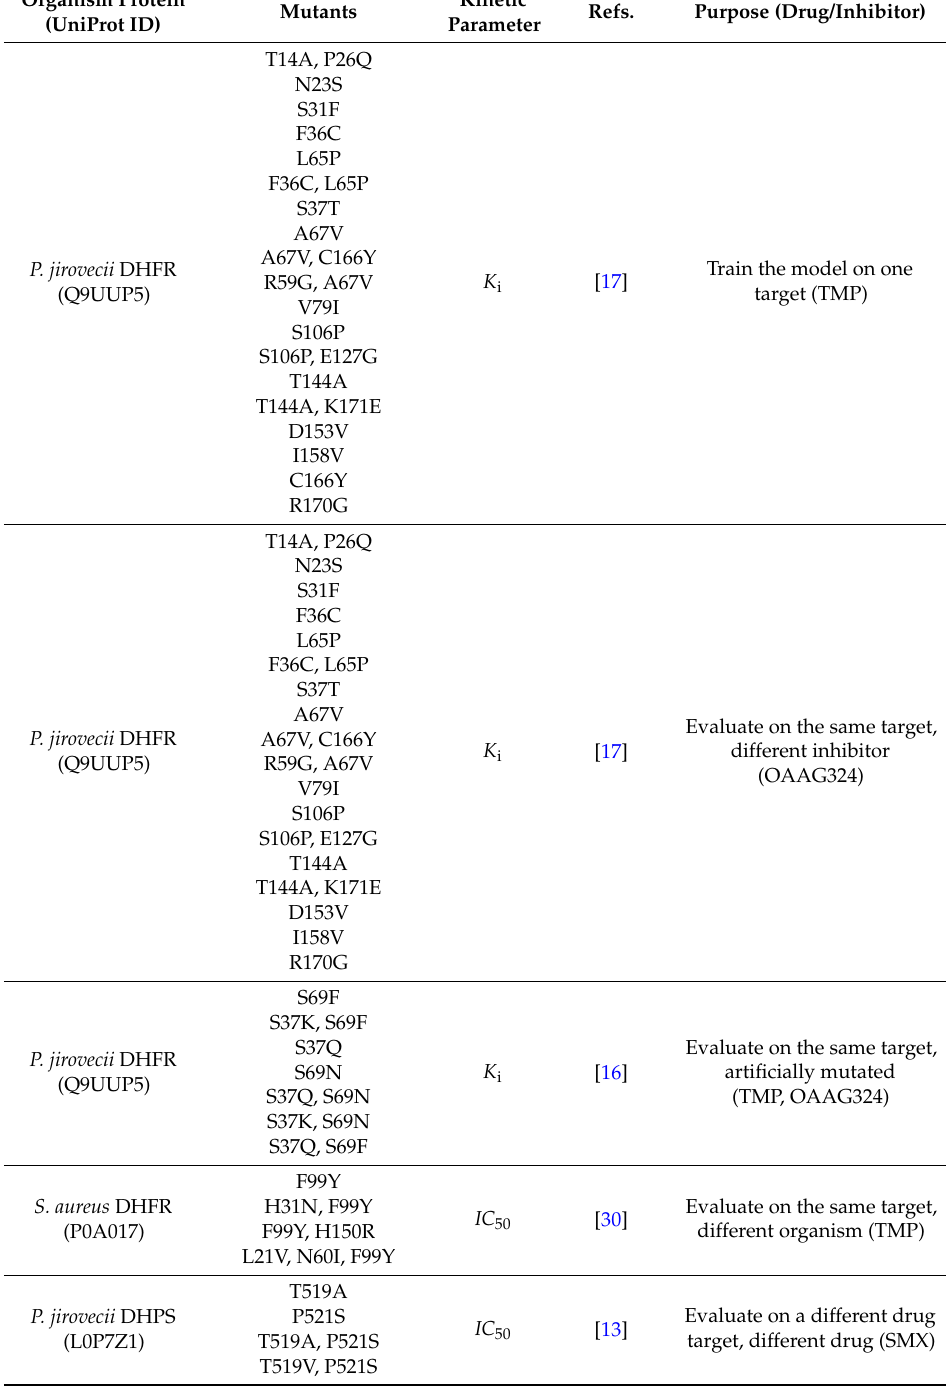
Table 1. Experimental data used to build and evaluate the model for the estimation of drug